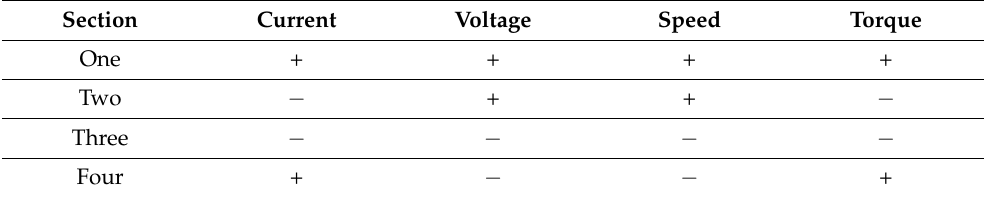
Table 6. Comparison of torque, speed, voltage, and current related to the movements of EVs. Section Current Voltage Speed Torque One + + +